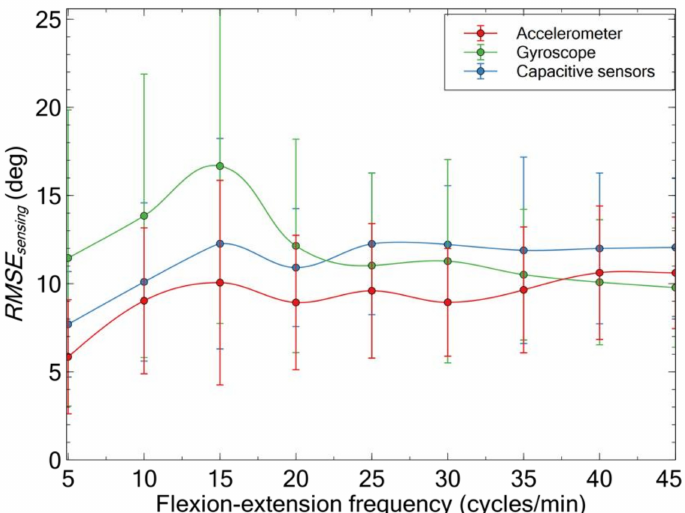
Figure 6. Comparison of the accuracy of the different wearable sensing technologies, as quantified by the root mean square error between the signal measured by each wearable sensor and the stereophotogrammetry signal, for cyclic flexion-extensions at different frequencies. Each data point is originated by the average among 10 volunteers, considering two repetitions for each volunteer. The error bars represent the standard